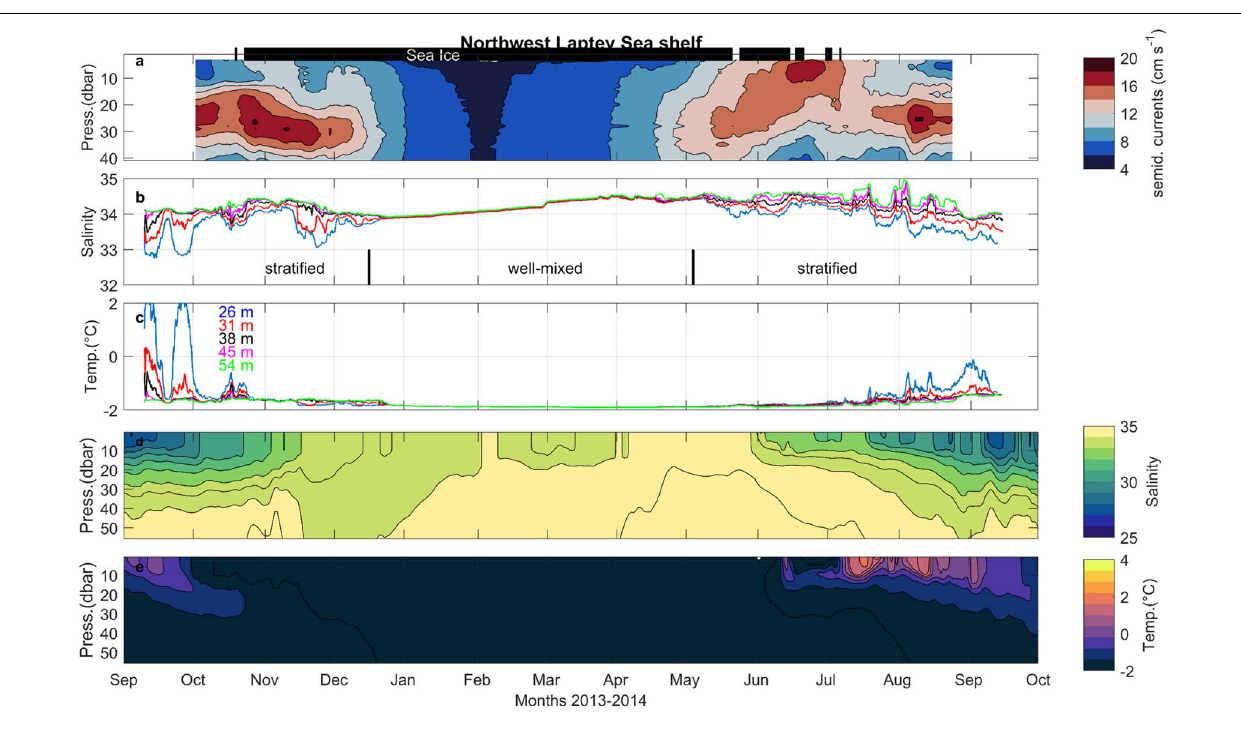
FIGURE 8 | Northwest Laptev Sea shelf mooring record of (a) semidiurnal currents (cm s − 1 ) overlain by sea ice cover at the top of the panel; (b) salinity and (c) temperature from SBE37 microcats moored in different depths indicated by colored text in the panel; (d) salinity and (e) temperature ( ◦ C) vs. depth (m) from Mercator from Septembers 2013 to